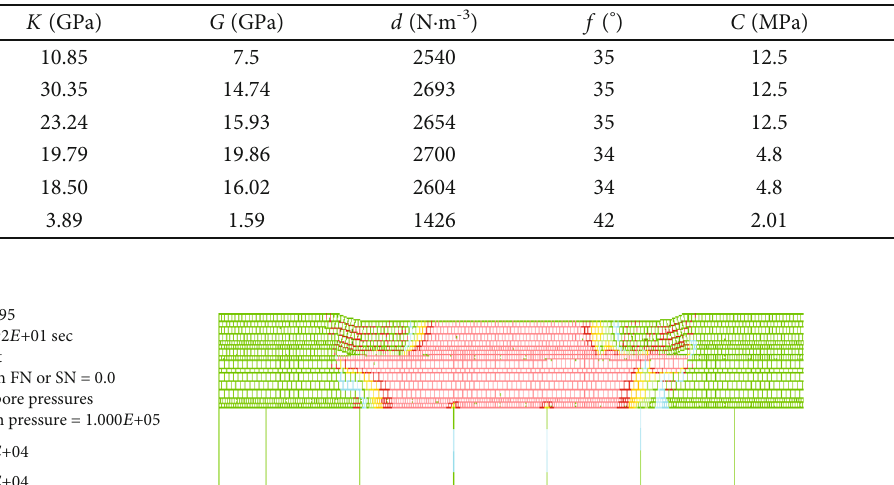
Figure 1: The numerical calculation model of gas discharge of carbon monoxide. Table 1: The physical parameters of rock mass.